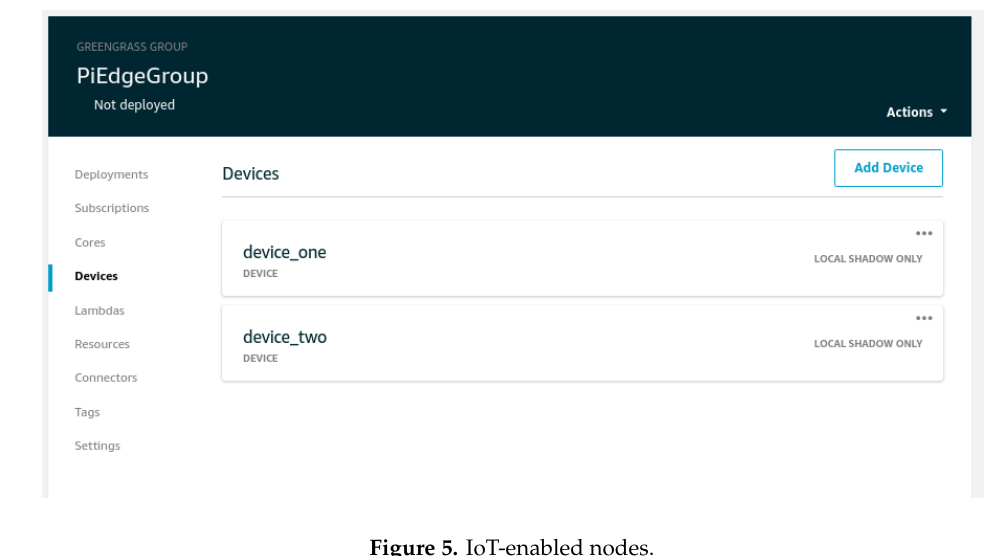
Figure 5. IoT-enabled nodes. Appl. Sci. 2020 , 10 , x FOR PEER REVIEW